Question: According to the figure, is the described quantity increasing or decreasing?
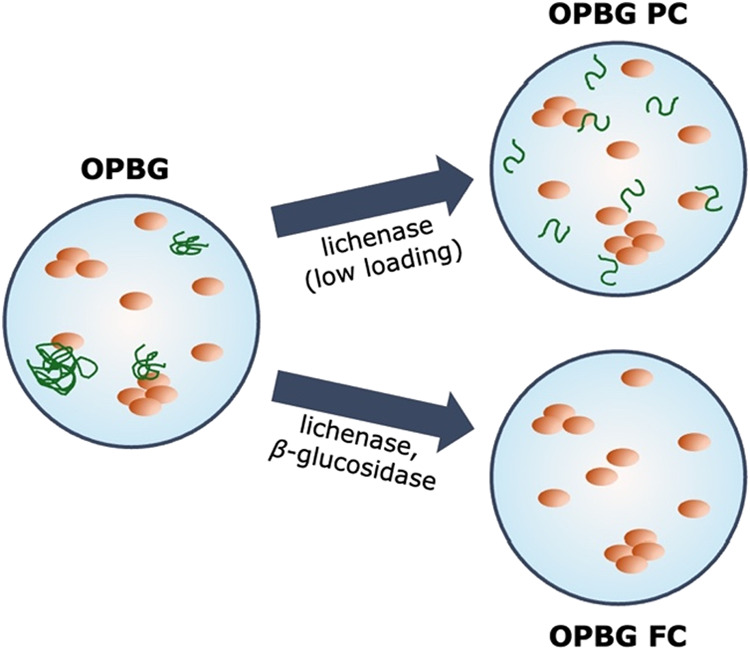
Answer: increasing